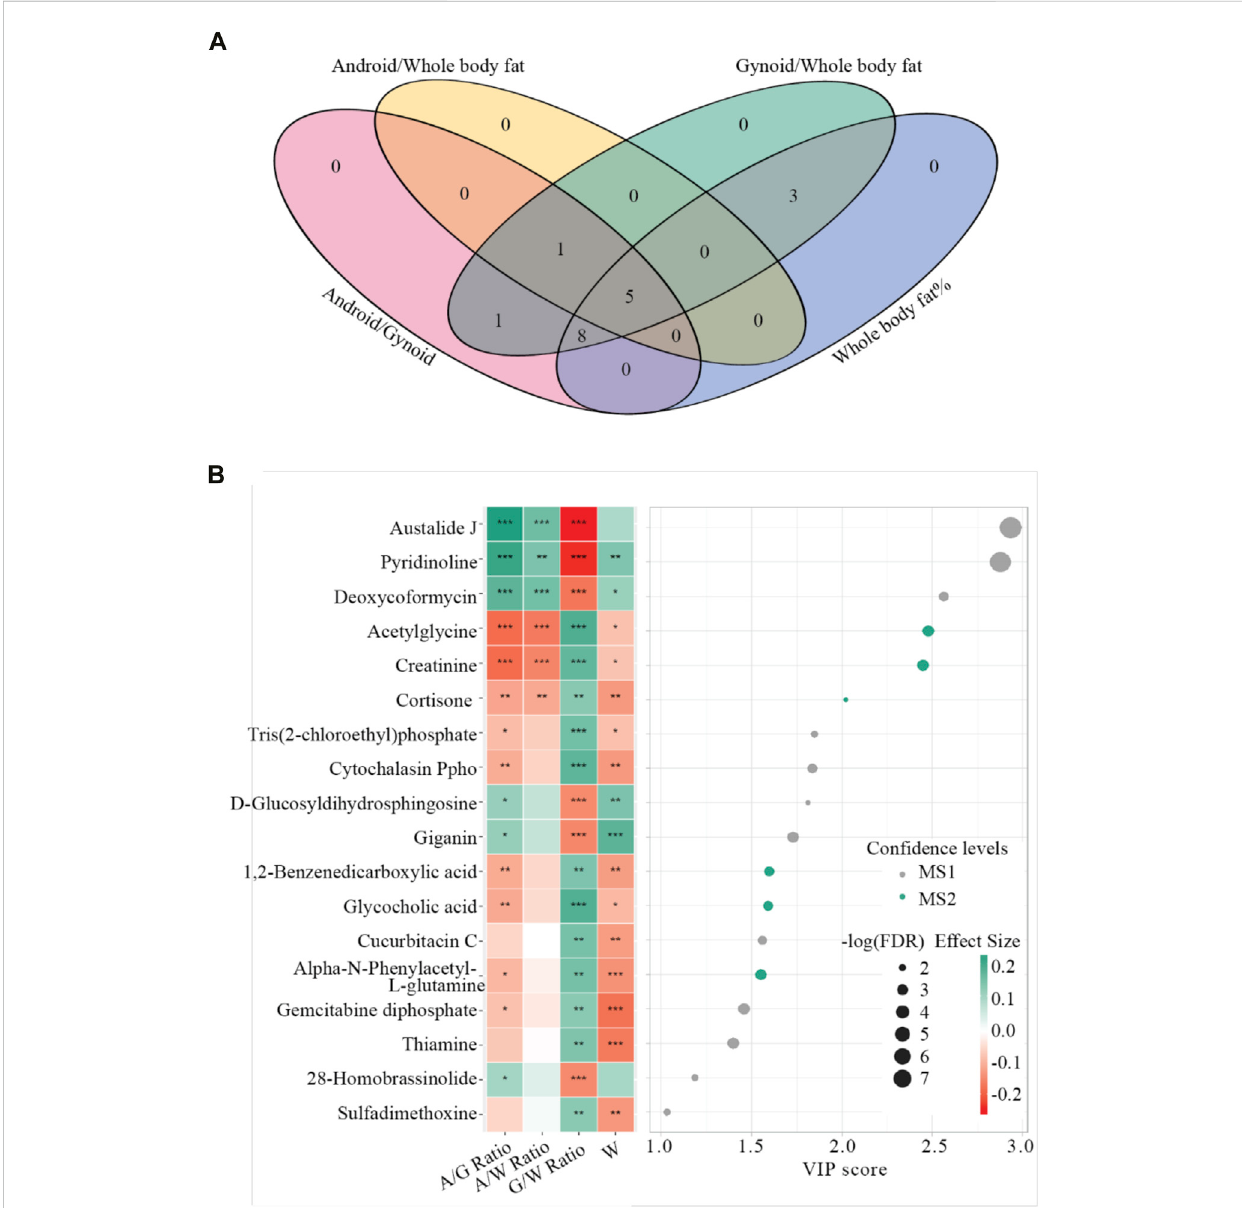
FIGURE 1 Summary results for the joint analysis in the discovery cohort. Panel (A) Venn diagram depicting metabolite sets that were signi fi cantly associated with body fat traits (FDR q-value < 0.2 and VIP > 1). Traits are represented by ovals of different colors. The number in each area represents the count of identi fi ed BF-associated metabolites associated with the given traits. Panel (B) . Important metabolites selected on the basis of VIP, score > 1 and FDR q-value ≤ 0.2. Each tile represents the effect size of the metabolite on each trait. VIP: the variable importance in projection scores, FDR: false discovery rate, A/W ratio: Android fat/Whole body fat ratio, G/W ratio: Gynoid fat/Whole body fat ratio, A/G ratio: Android fat to gynoid fat ratio, and W: Whole body fat %. *: p -value < 0.05; **: p -value < 0.01; ***: p -value <